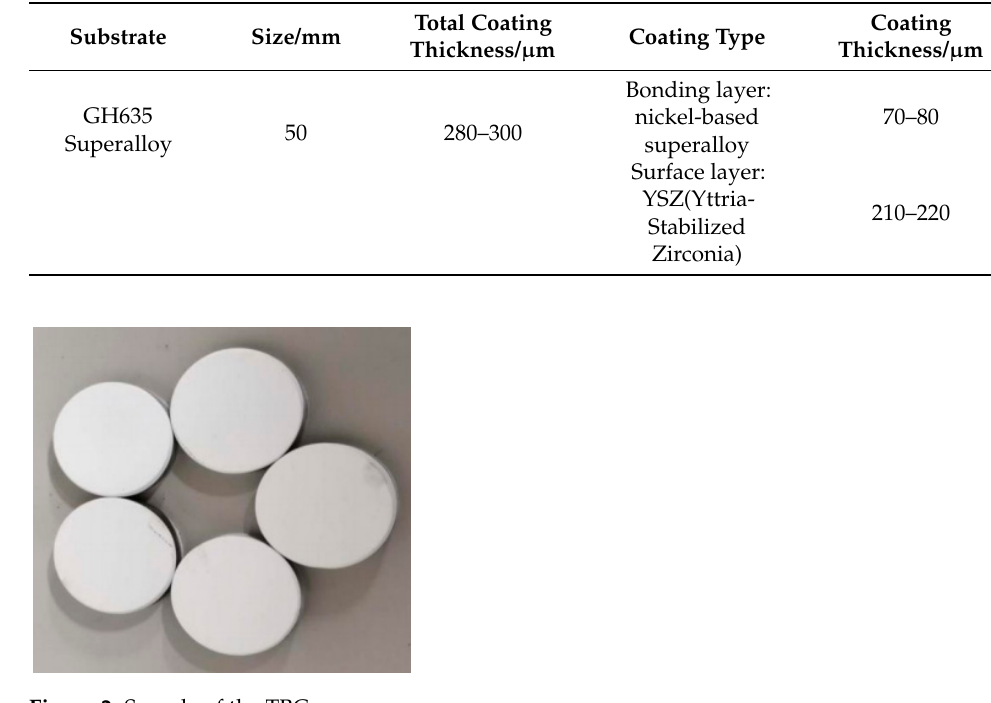
Figure 2. Sample of the TBC. Table 2. Sample parameters.